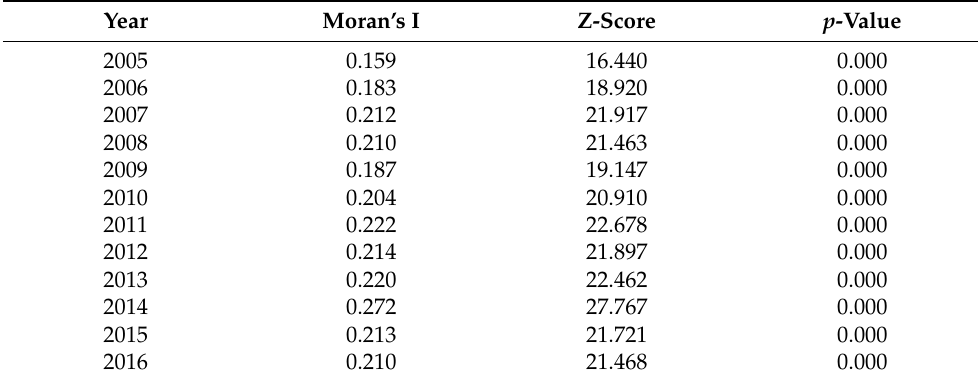
Table 6. Global spatial correlation coefficient (Moran’s